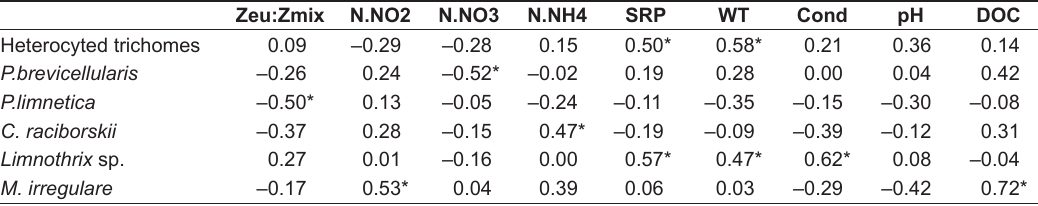
Table 4. Spearman correlation coefficient performed between phytoplanktonic species and limnological